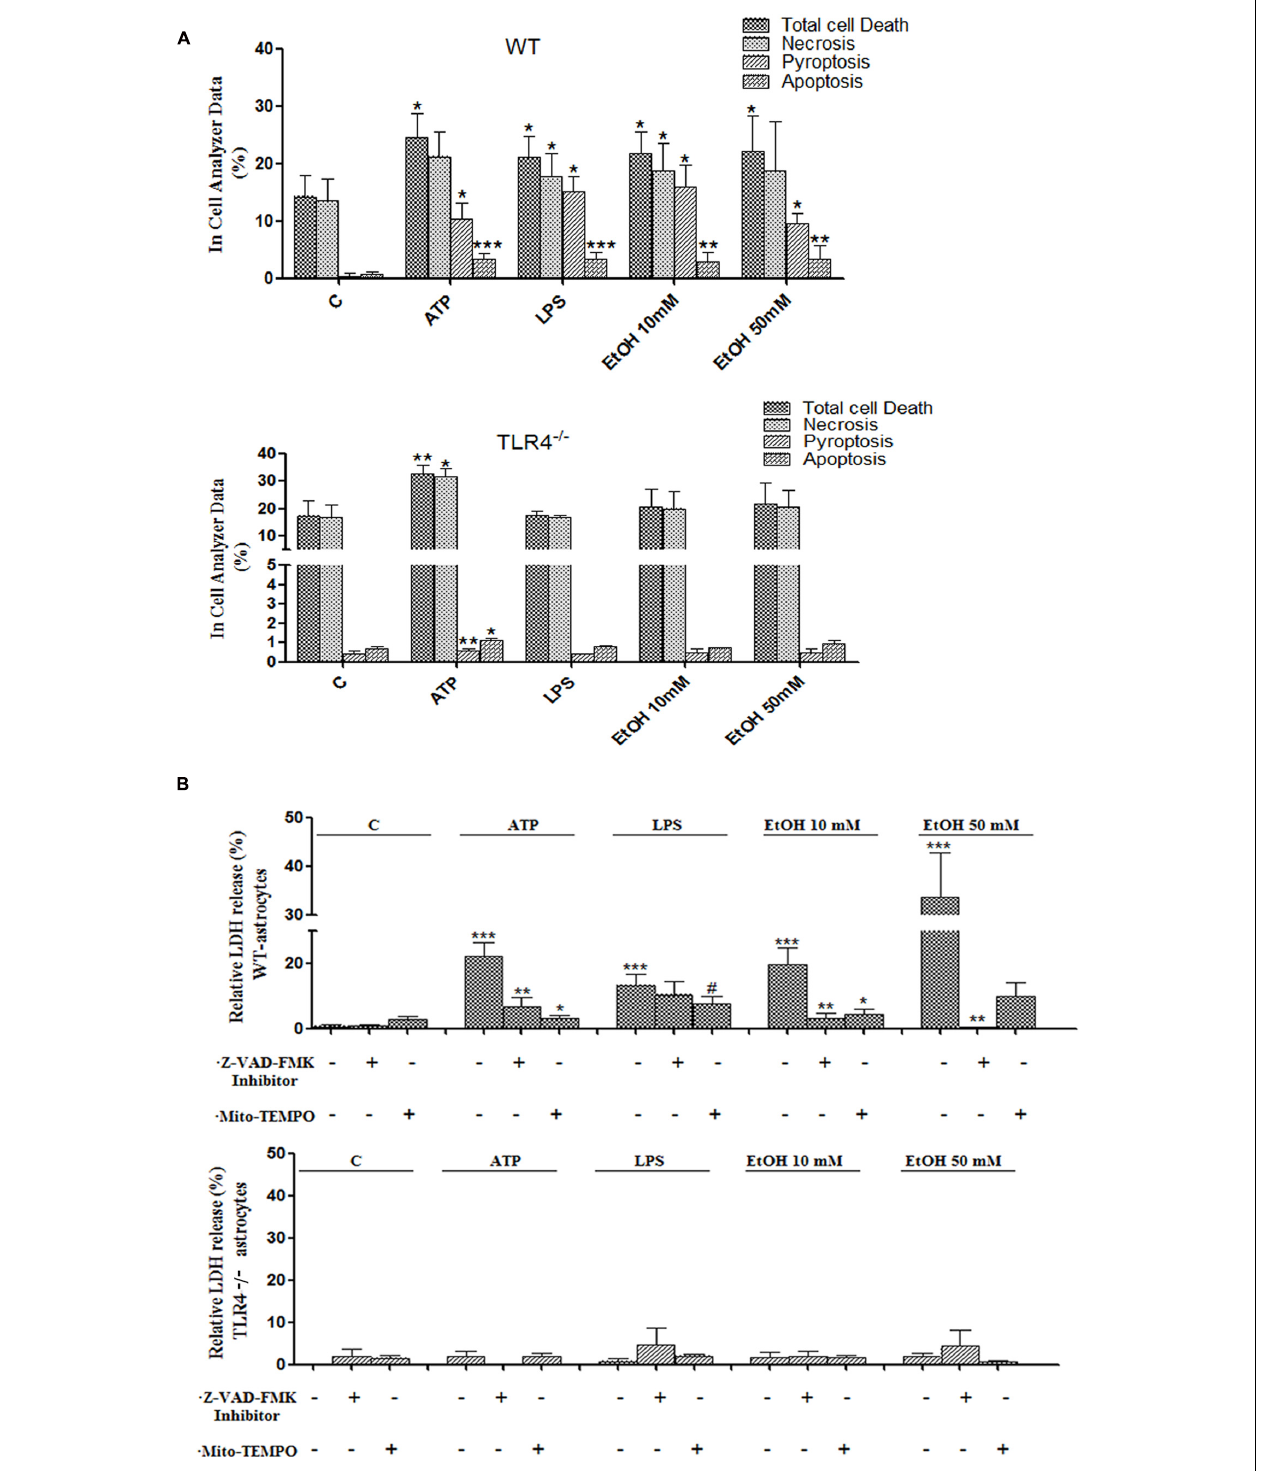
FIGURE 7 |Activation of the NLRP3 inflammasome complex triggers pyroptosis and apoptosis in ethanol-induced astroglial cells. (A) Bars show the percentage of cell dead by pyroptosis, necrosis and apoptosis in astrocytes treated for 24 h with ATP, LPS, and ethanol (10 and 50 mM) evaluated by an In Cell Analyzer. Approximately 1000–5000 cells were